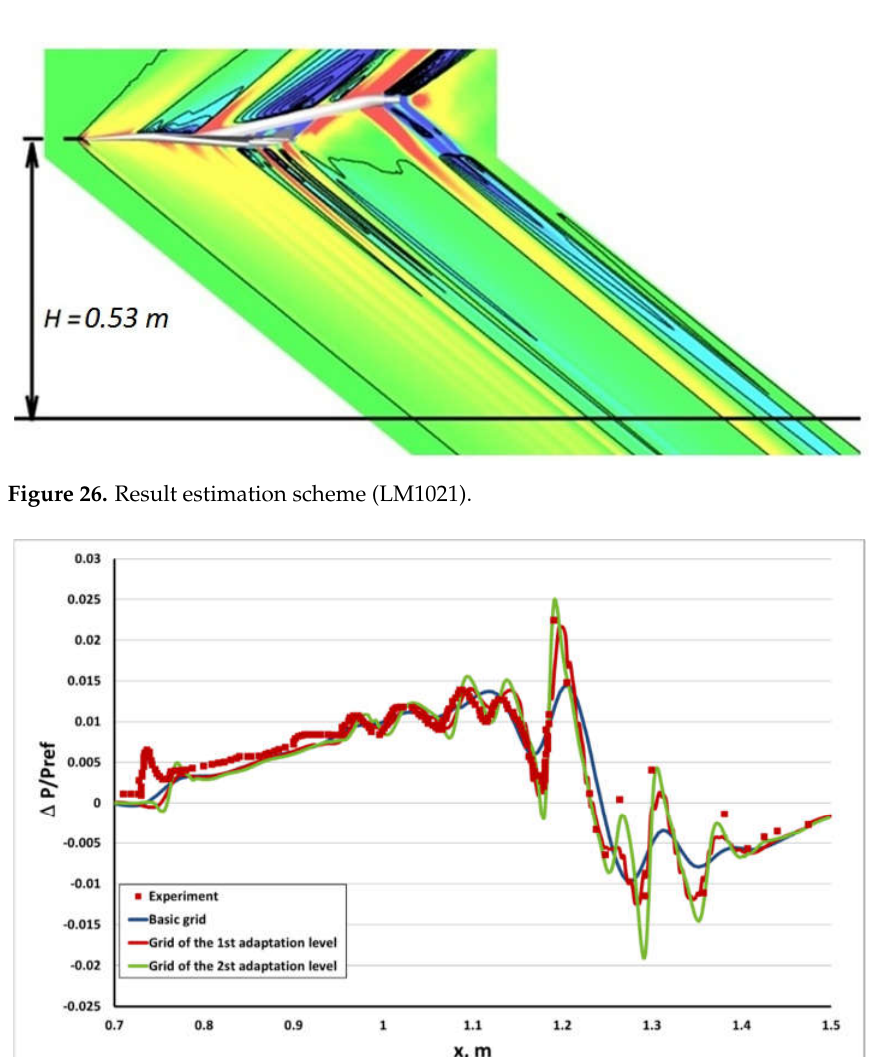
Figure 27. Normalized variation of static pressure (LM1021).